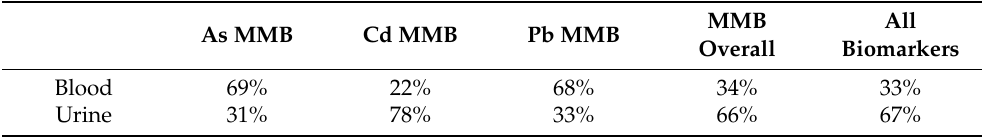
Table 4. Weights highlighting the contribution of each biomarker to the mixture effect of metals on eGFR. Larger weights indicated higher contributions to the mixture effect.